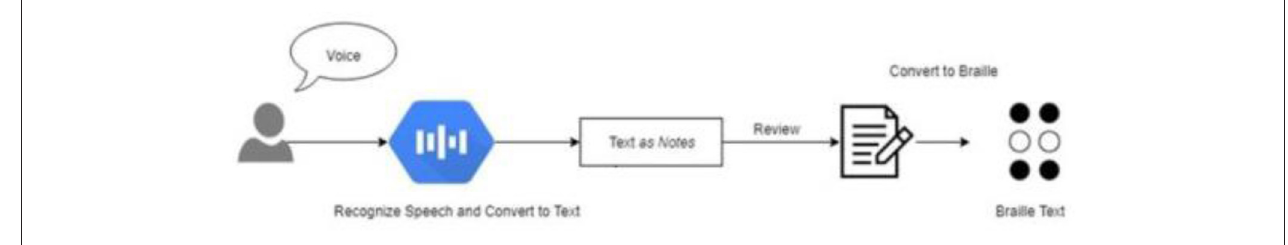
FIGURE 11 | Spoken Arabic Digit to